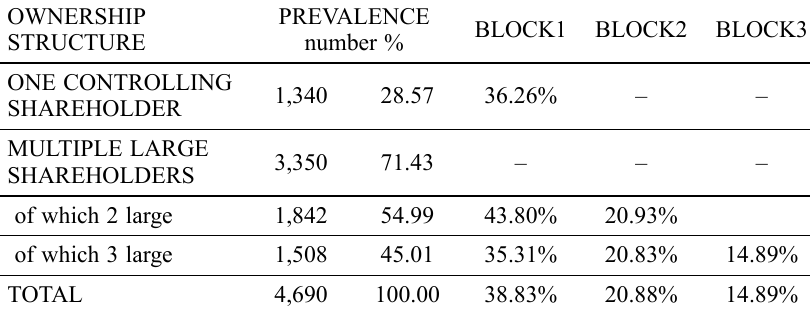
Table 3. Ownership concentration and the importance of complex structures OWNERSHIP